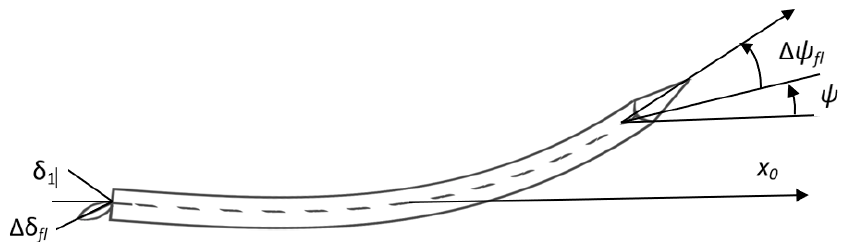
Figure 3. Deflection of the aircraft under the control torque.